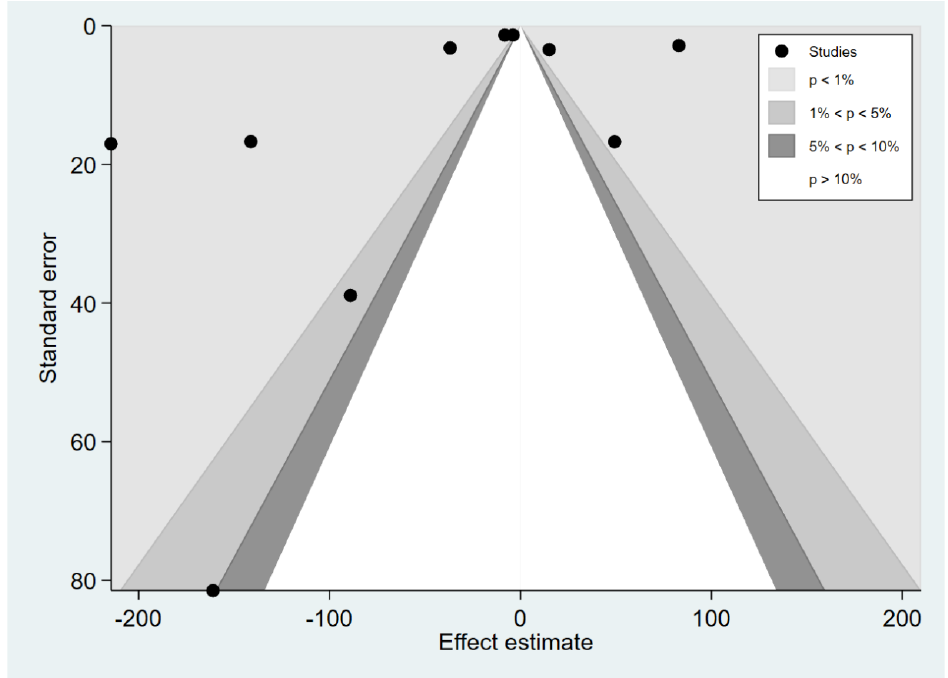
Figure 11. Contour-enhanced funnel plot demonstrated the distribution of the mean difference of IL-12 levels between severe and uncomplicated malaria from each study. In addition, the funnel plots showed the distribution of the mean differences and the standard error (se) of the mean differences in both significant and non-significant areas.